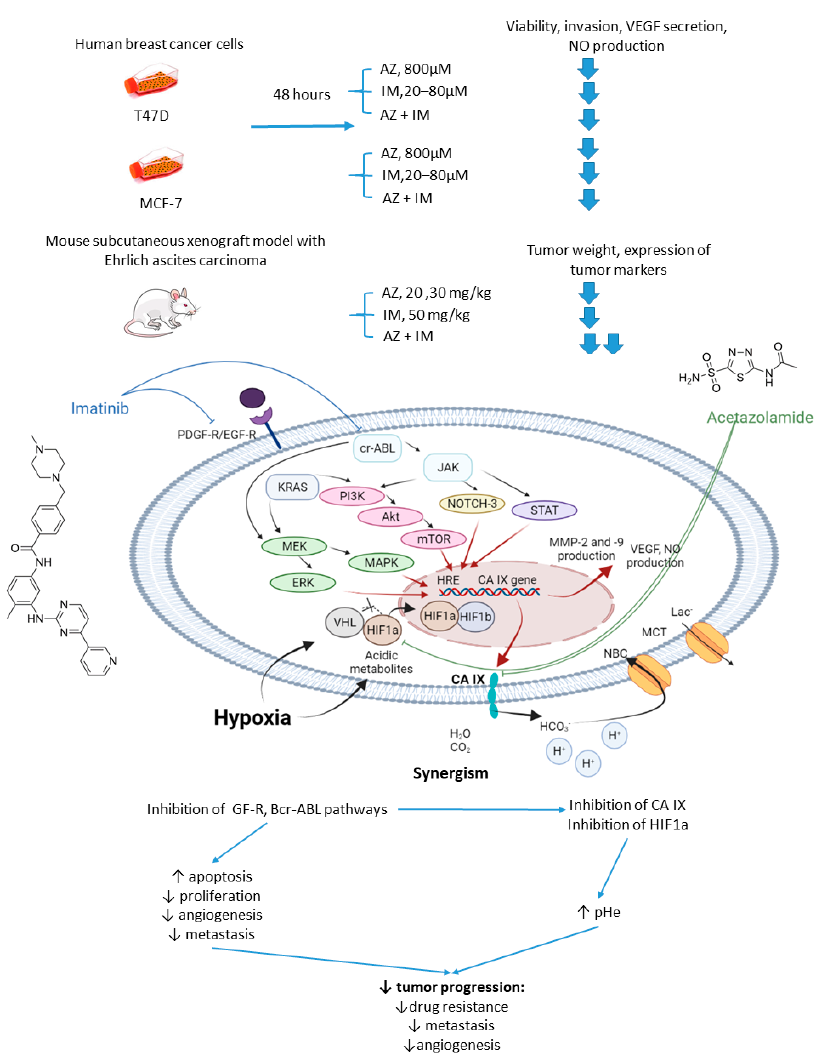
Figure 6. Graphical outline of the study on AZ+IM combination reported by Abd-El Fattah et al., and summary on the hypothesized molecular interactions resulting in the synergistic action of the drugs [54].